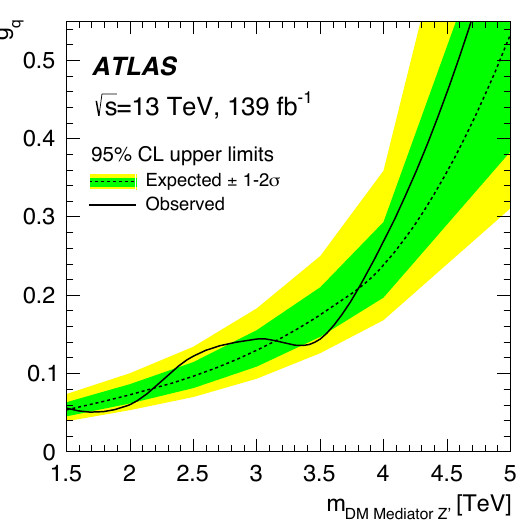
Figure 5 . The upper limits on the DM mediator Z 0 signal at 95% CL from the inclusive category, with the selection described in the text and summarised in table 1. The 95% CL upper limits are set on the universal quark coupling g as a function of the Z 0 mass. The observed limits (solid) and q expected limits (dashed) with (cid:6) 1 (cid:27) and (cid:6) 2 (cid:27) uncertainty bands are